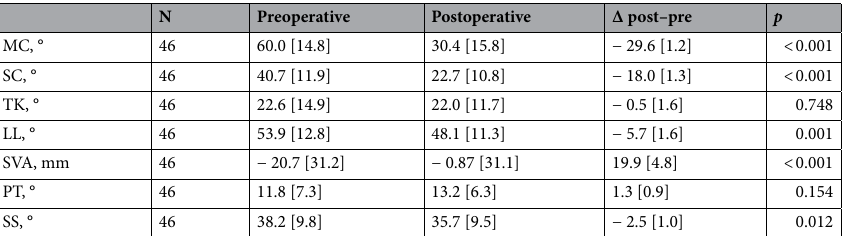
Table 3. Radiographic parameters in group 2 (hybrid group); mean [standard deviation]; analysis performed using IBM SPSS Statistics 21. LL, lumbar lordosis; MC, Cobb angle of the main curve; N, number of patients; PT, pelvic tilt; SC, Cobb angle of the secondary curve; SS, Sacral Slope; SVA, sagittal vertical axis; TK, thoracic kyphosis.